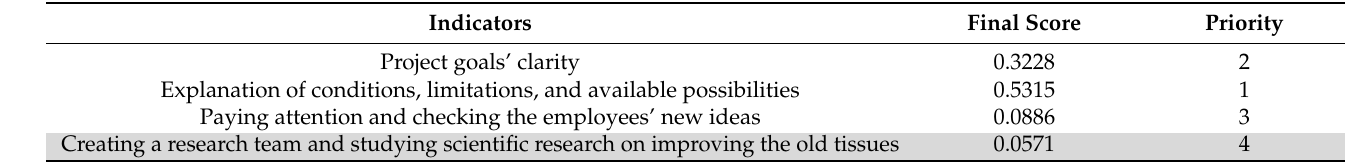
Table 22. Priority related to attention to idea creation indicators.